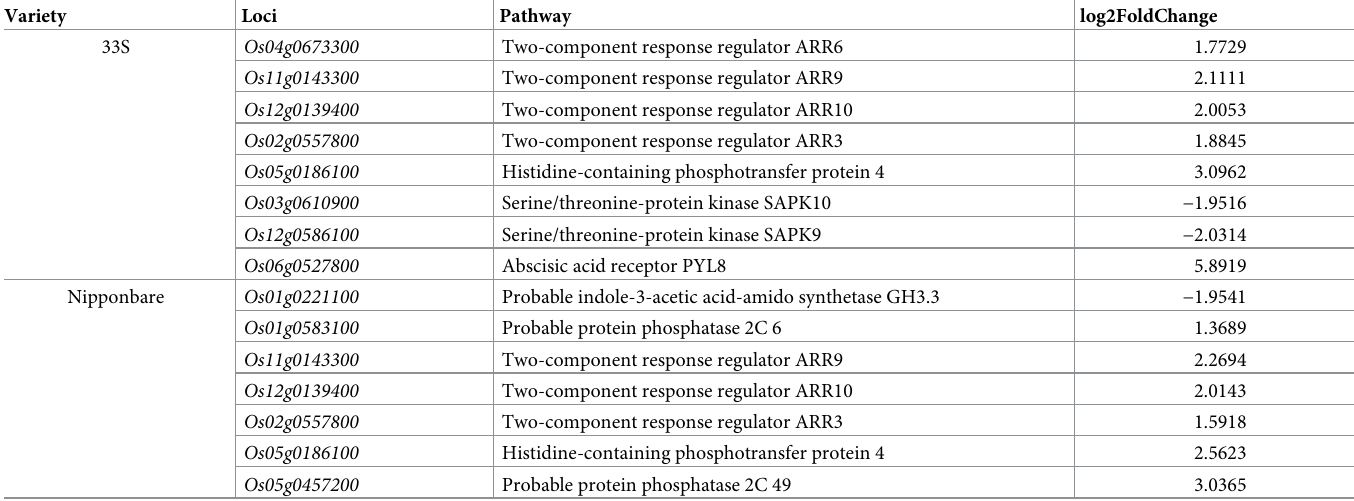
Table 1. List of DEGs enriched in plant hormone signal transduction.